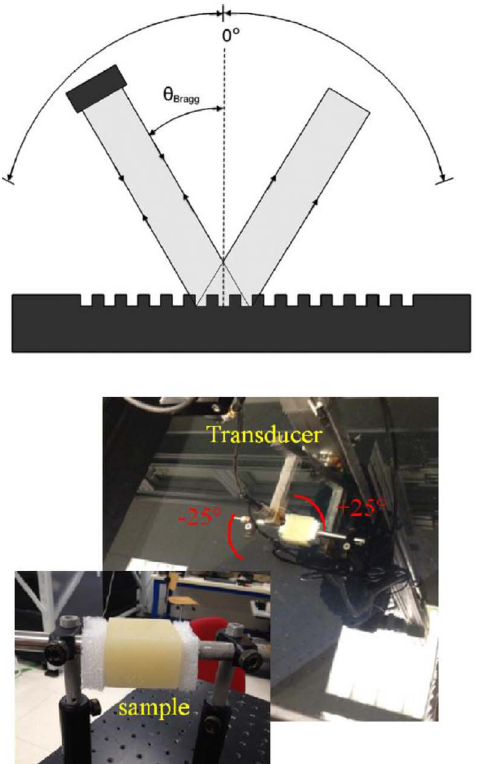
Figure 3. (Top) Schematic view of a polar scan for capturing backscattered waves at Bragg angles [26]. (Bottom) Photograph of the experimental setup of polar scan on the bi-material